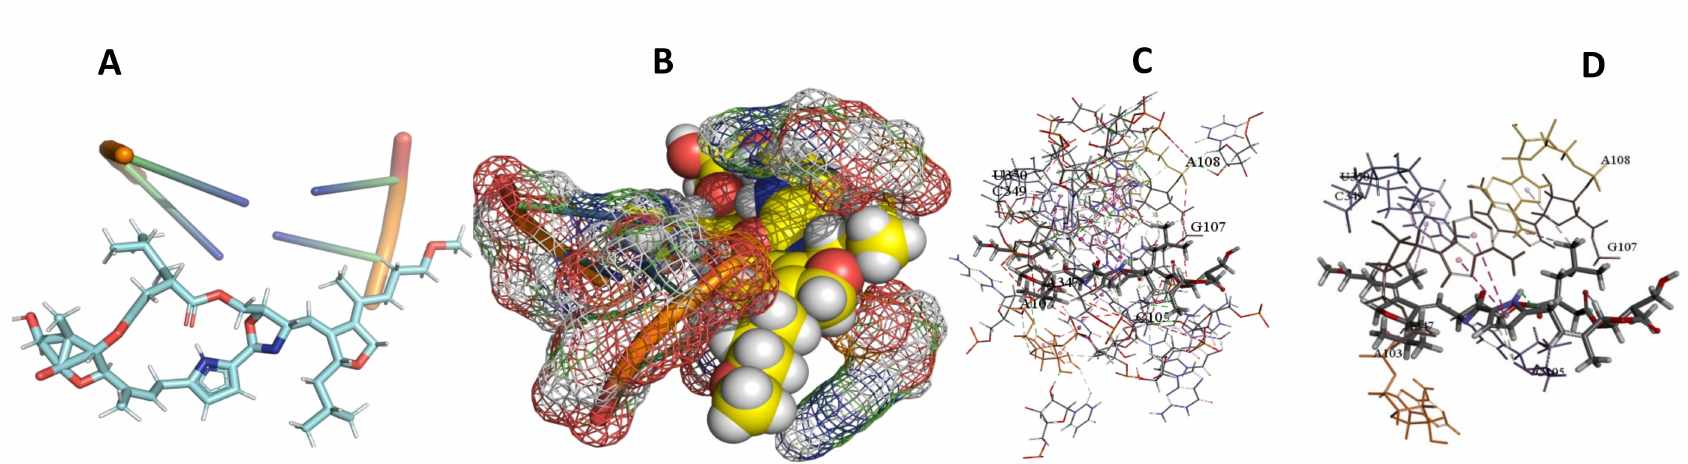
Figure 24. L. major + leupyrin. ( A ): Best binding pose and nucleotides involved. ( B ): Schematic binding pocket. ( C ): shows the Nucleotides component that re involved in binding. ( D ): Shows the main bonds involved between the compound and the nucleotide component.